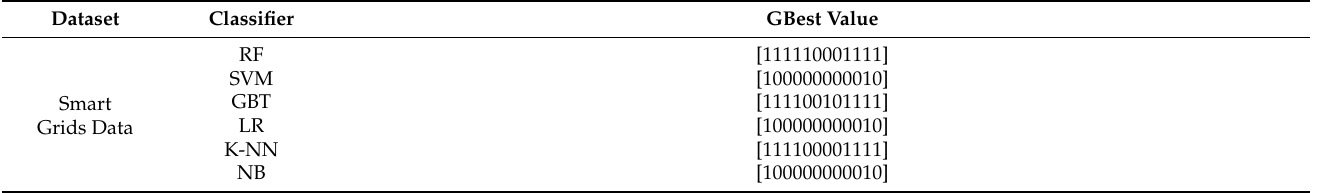
Table 5. BHOA GBest Values Results